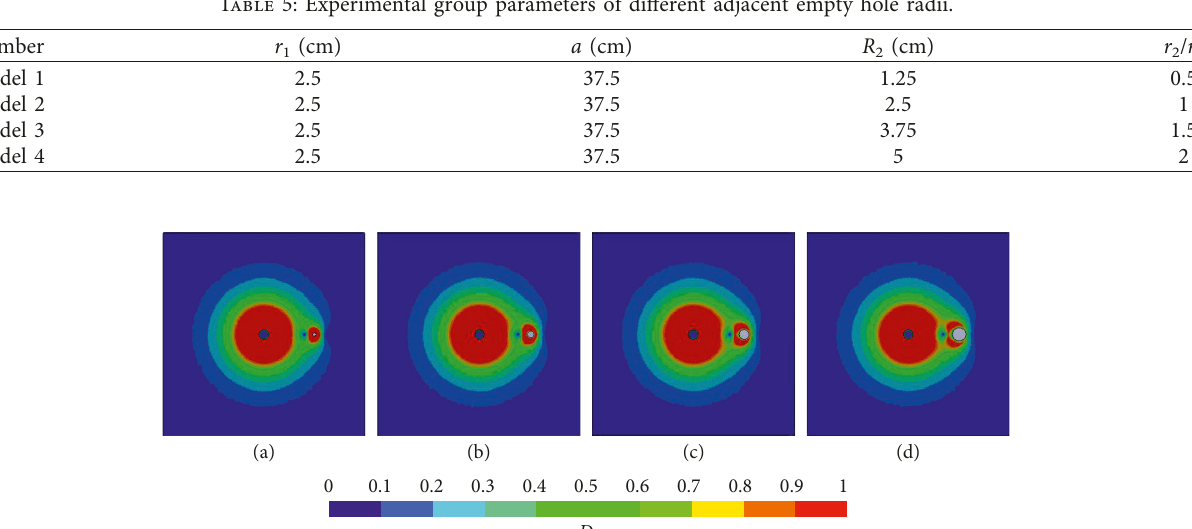
Figure 12: Damage distribution with different adjacent empty hole radii when t � 25 μ s. (a) r (d) r 2 / r 1 �